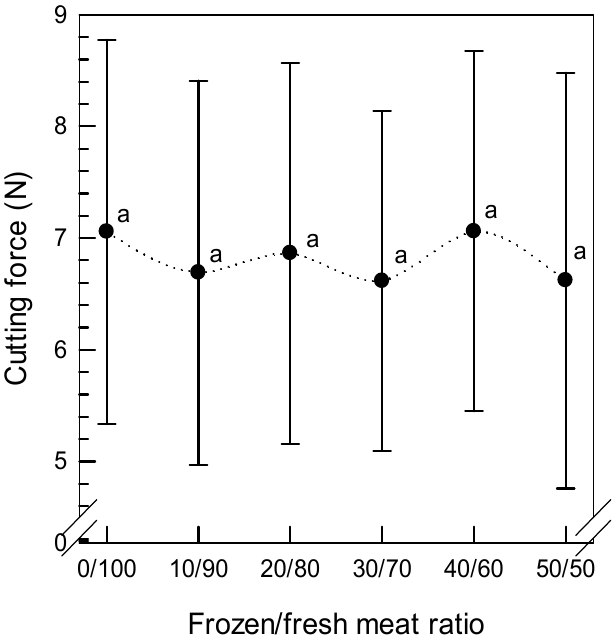
Figure 3. Cutting force (n = 32) (mean ± standard deviation) of minced meat with varying frozen to fresh meat ratios. Different letters indicate significant differences ( p < 0.05).